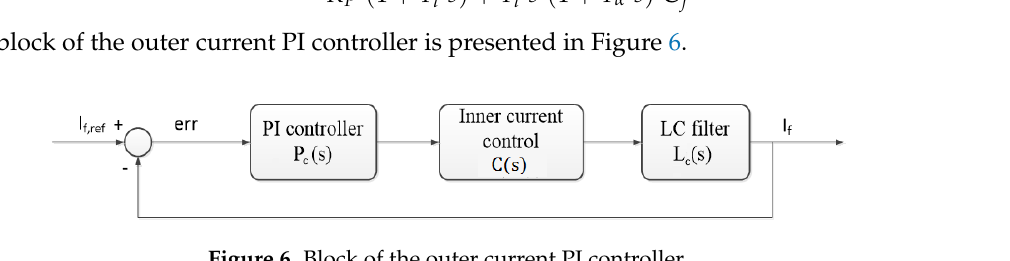
Figure 6. Block of the outer current PI controller.